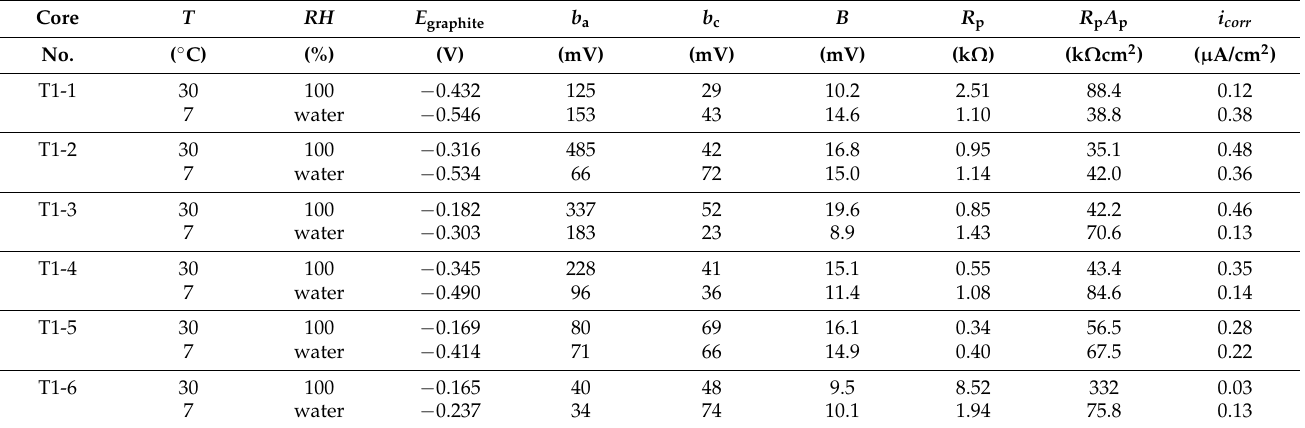
Table A1. Results of the analysis of polarization curves for steel reinforcement in cores drilled from the tank T1.